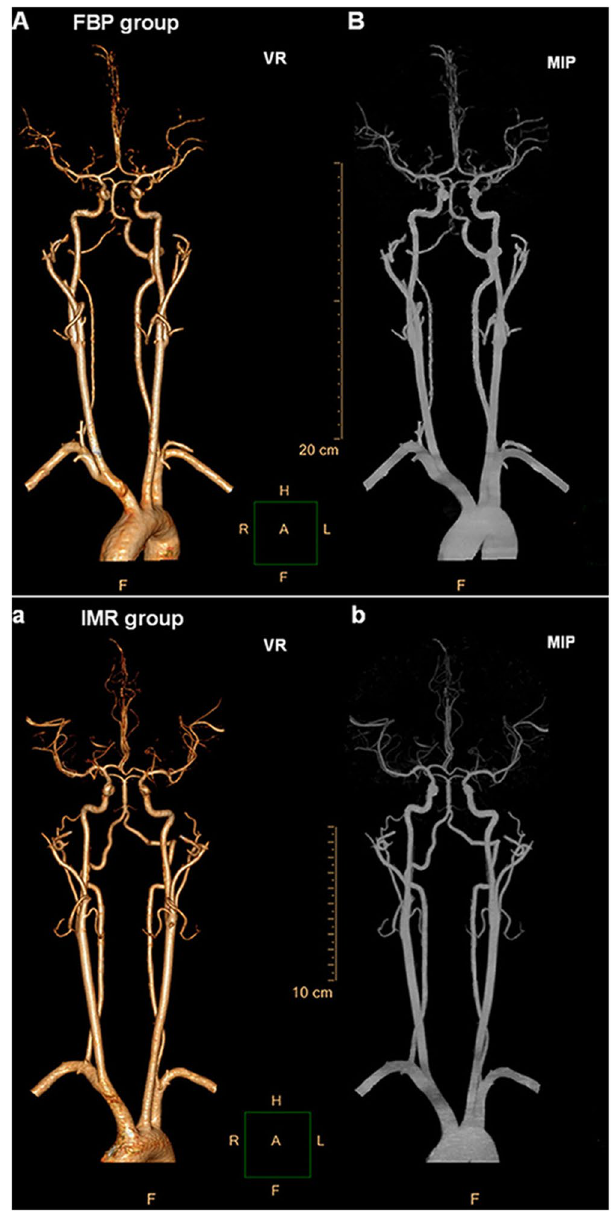
Figure 3. Measurements of the subjective image quality in the head and neck CTA of two 12-year-old boys reconstructed with the FBP algorithm and the IMR algorithm. ( A , B ) show the VR and MIP images of the FBP group, while a and b show the VR and MIP images of the IMR group. The subjective image qualities of both groups were rated as excellent (p < 0.01). The IMR group obtained a better image quality than that of group A (p < 0.01). Abbreviations: VR, volume rendering; MIP, maximum intensity